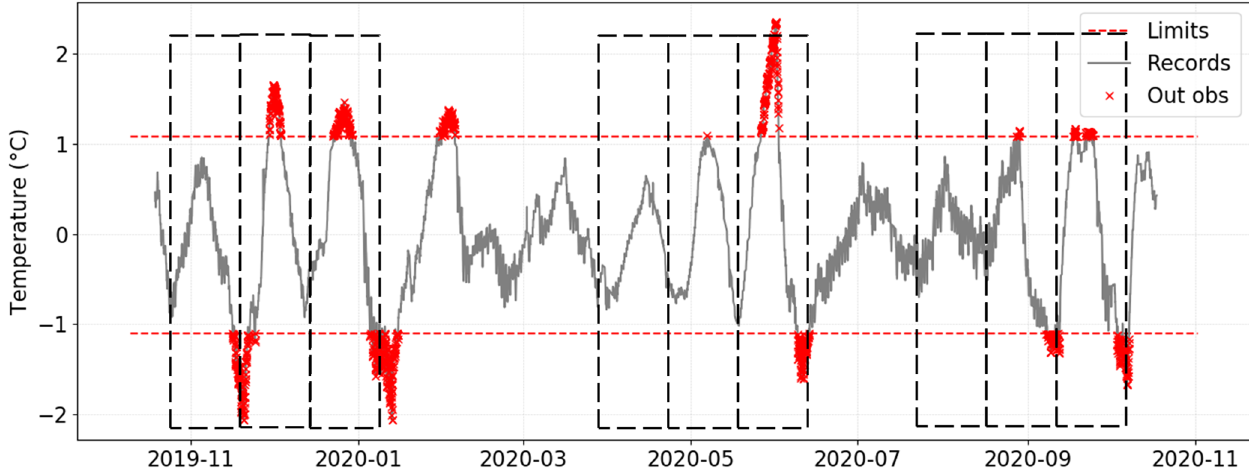
Figure 6. Short-term fluctuations of temperature for data-logger C5. Security limits according to EN 15757:2010 are depicted as dashed lines in red. Vertical equidistant dashed lines highlight instants of time when the time series reaches a minimum.